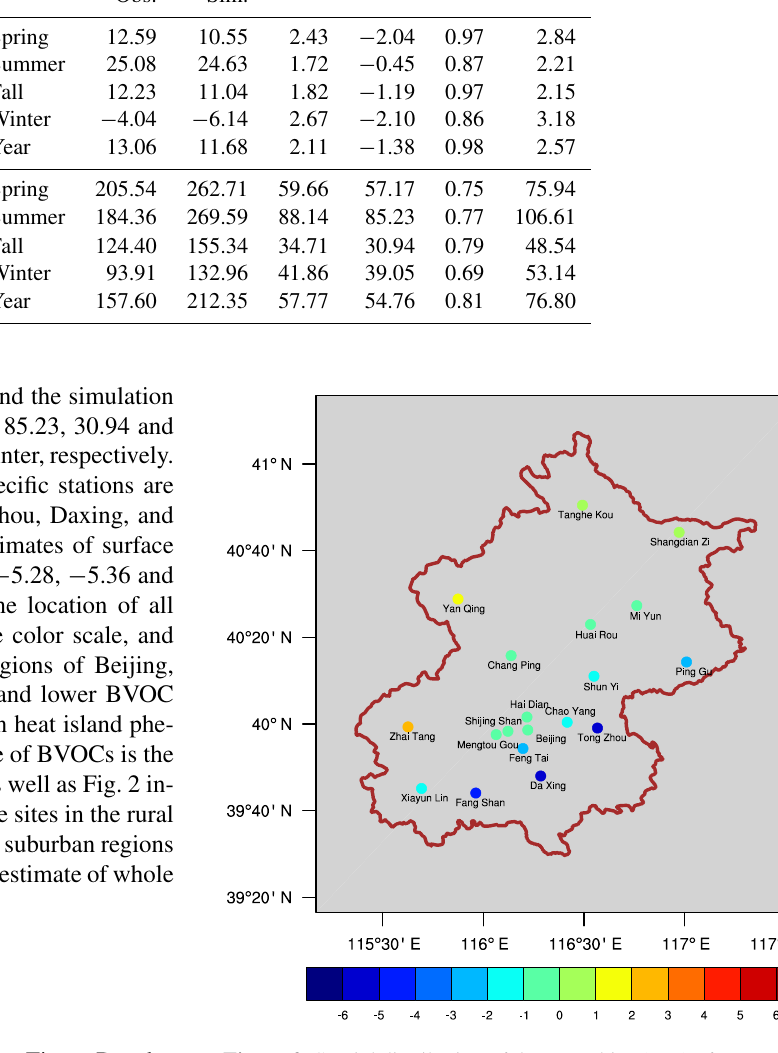
Table 2. Verification statistics of hourly temperature at 2m height (T2) and daily downward shortwave radiation (DSW). ME, MB and RMSE are abbreviations for mean error, mean bias and root-mean-square error, respectively. Variable Season Mean ME MB r RMSE Obs. Sim. Spring